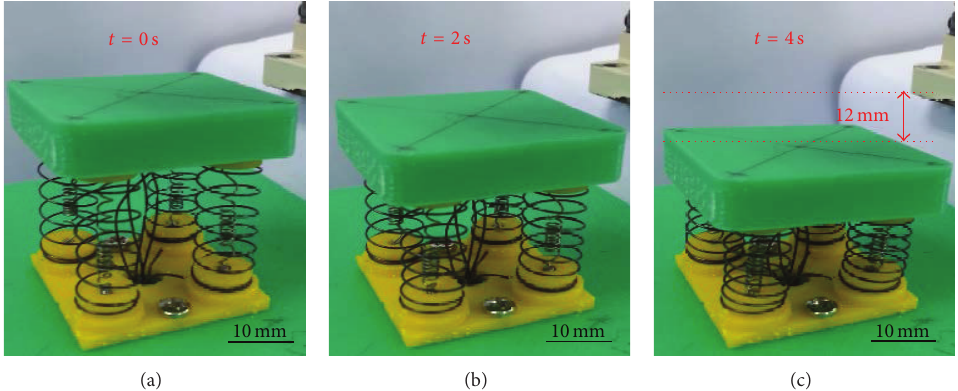
Figure 15: Linear 𝑧 -axis motion height control of miniature Stewart platform prototype; (a) initial state; (b) four-limb actuation ( 𝑡 = 2 s); (c) four-limb actuation ( 𝑡 = 4